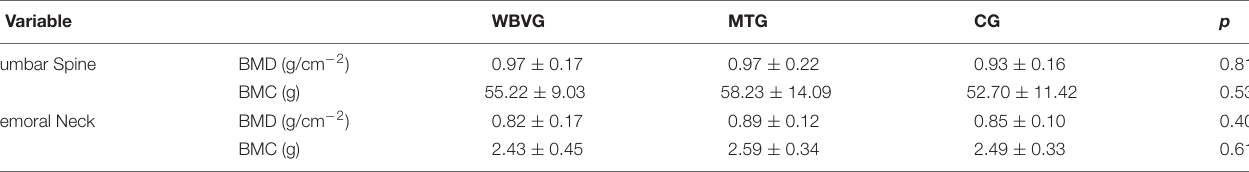
TABLE 3 | Baseline values for lumbar spine and femoral neck BMD and BMC for each group. Variable WBVG MTG CG p Lumbar